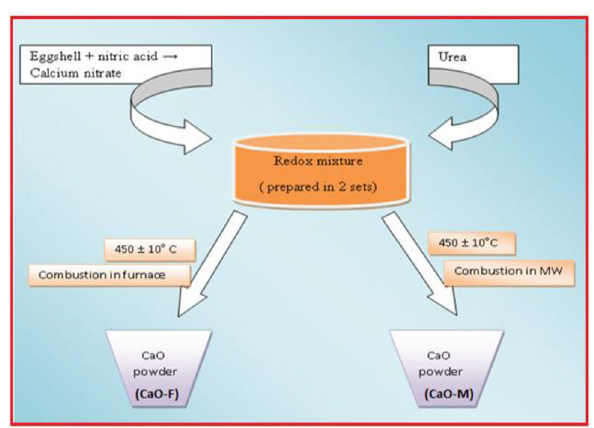
Fig. 1 Representation of synthesis of CaO-M and CaO-F